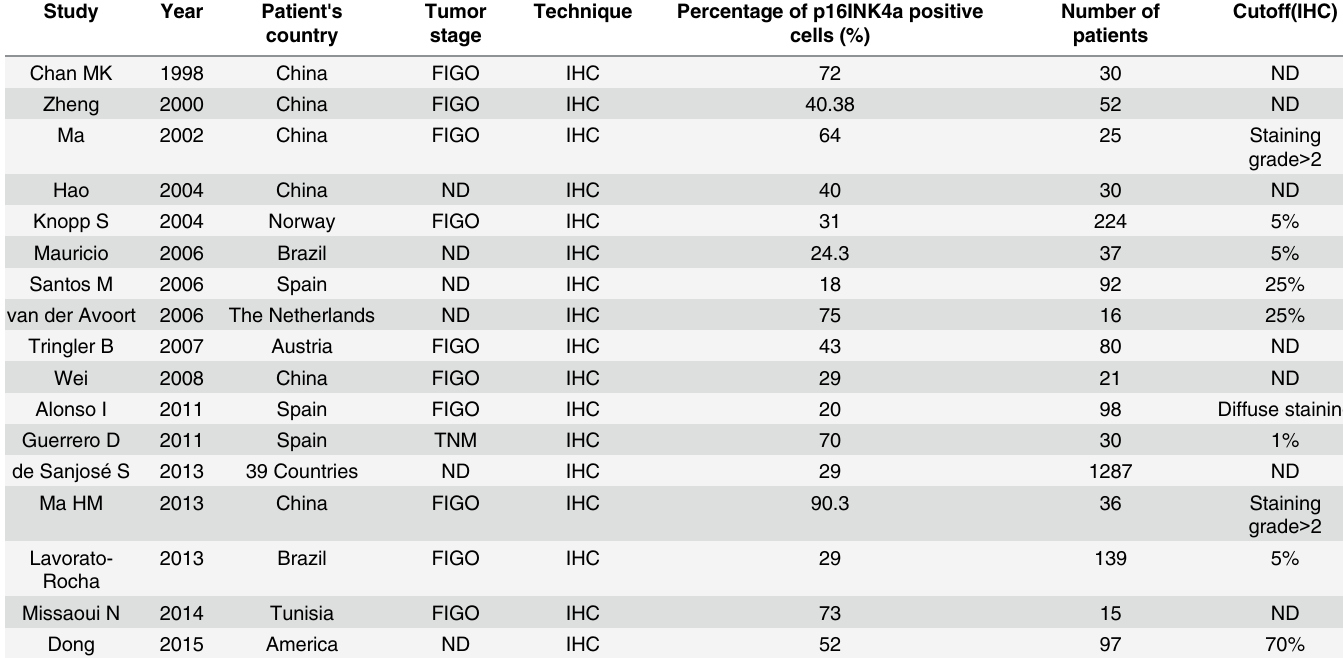
Fig 1. Flow chart demonstrating studies processed for inclusion in the meta-analysis. doi:10.1371/journal.pone.0152459.g001 Table 1. Main Characteristics of all Eligible